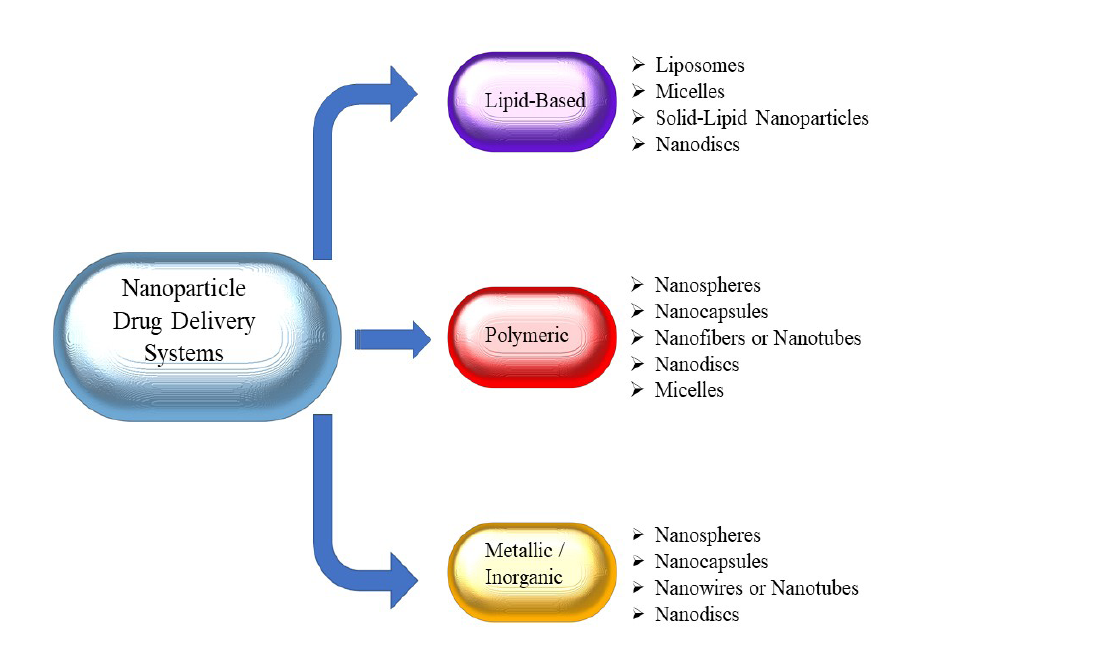
Figure 1 Overview of the relationship between nanoparticulate systems, divided by their structural